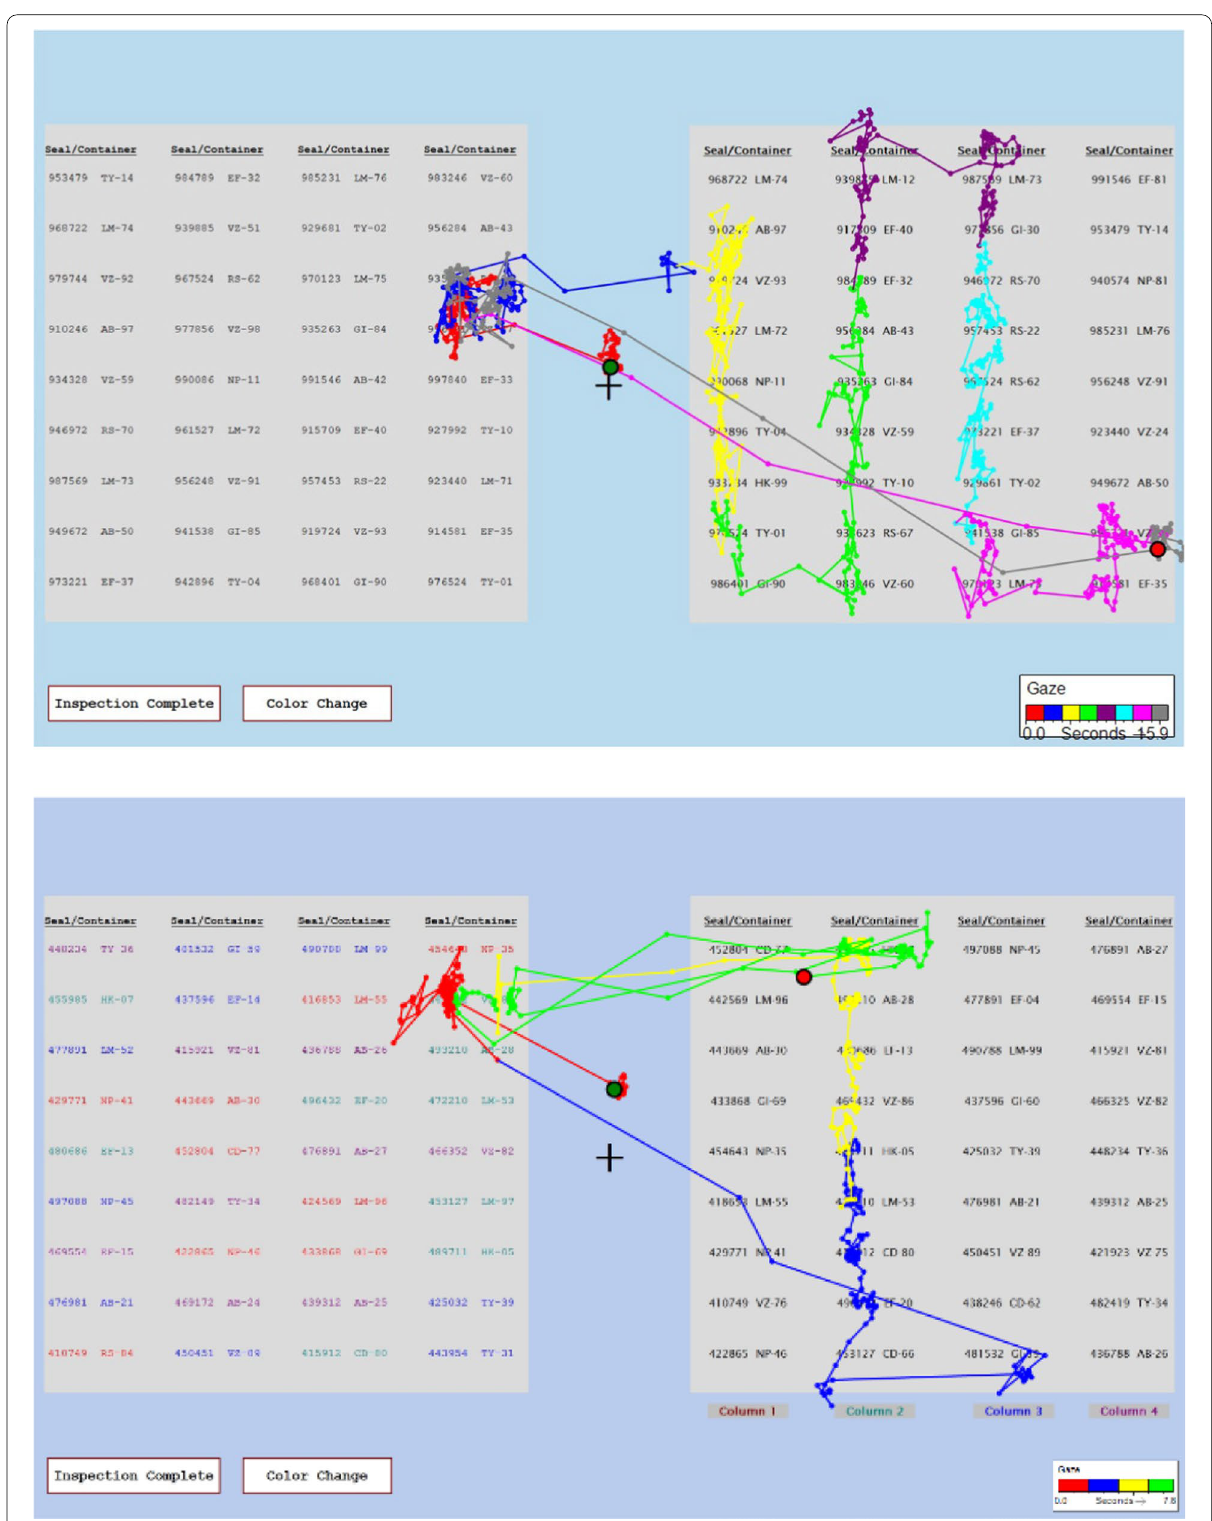
Fig. 10 Examples of scanpaths obtained from the eye tracking data. The top panel shows a trial from the Random Order, No Color condition and the bottom panel shows a trial from the Random Order, Color Coding condition. The location of the participant’s gaze at the start and end of the trial is marked with green and red circles, respectively. The smaller circles indicate the gaze position each time the eye tracker sampled the